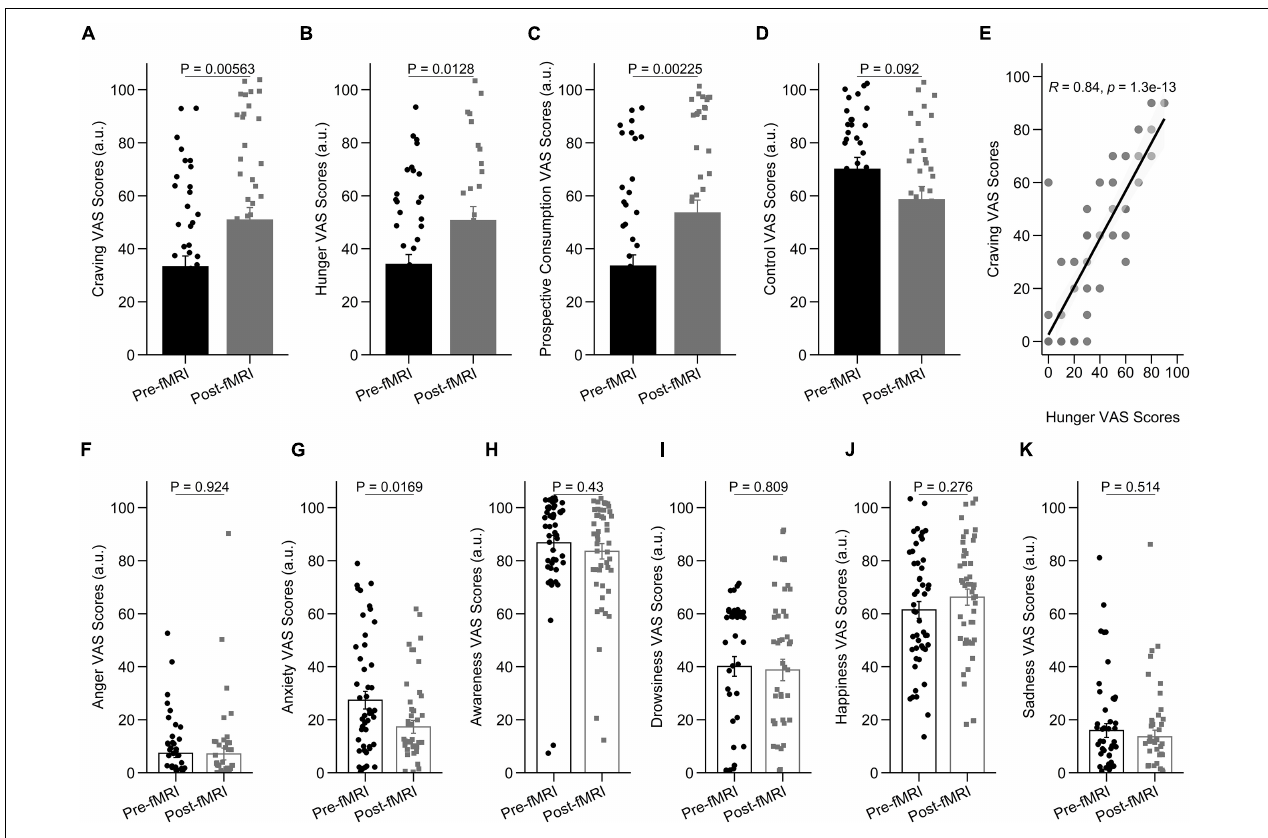
FIGURE 2 | Behavioral results in the cue-reactivity condition. (A–D) Representative bar charts showing main effect of cue-reactivity on (A) craving; (B) hunger; (C) prospective consumption; and (D) food control before and after food cue-reactivity task. (E) Participants’ scores on the self-reported craving and hunger were significantly positively correlated ( R = 0.84; P < 0.001; Pearson’s correlation). (F–K) Changes in self-reported score of affective states [anger (F) , anxiety (G) , awareness (H) , drowsiness (I) , happiness (J) , and sadness (K) ] before and after food cue-reactivity task. Data in bar charts are represented as mean ±